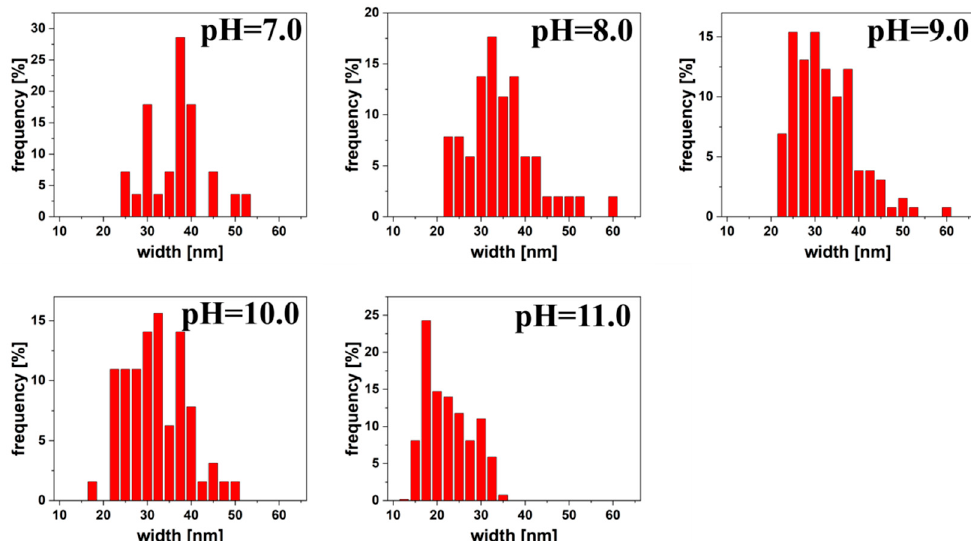
Figure 5. Distribution of rods width for silver colloids reduced by citric acid at pH 7.0 to 11.0.